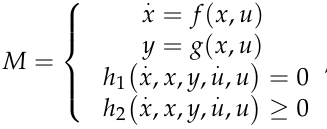
Figure 2. Each module can be defined by the phenomena that occurs within